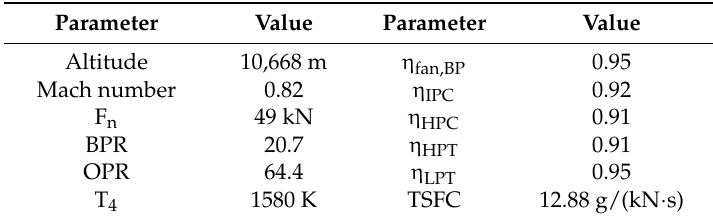
Table 2. Cruise performance parameters of the reference